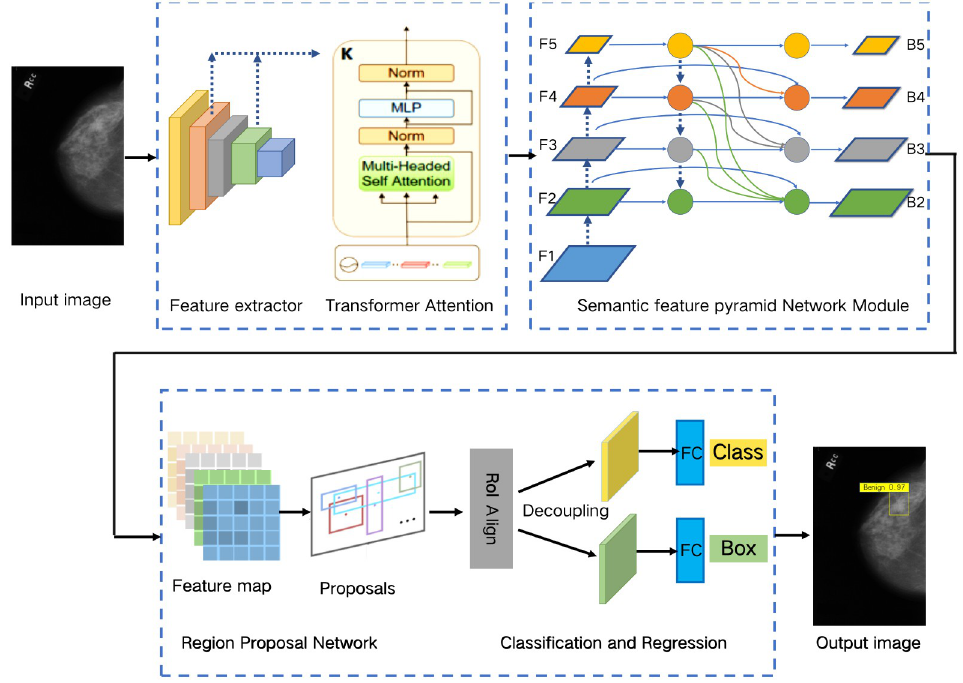
Fig 2. The overview architecture of proposed SPN-TS, including the following four parts, transformer attention feature extractor, semantic feature pyramid network module, region proposal network and classification and regression